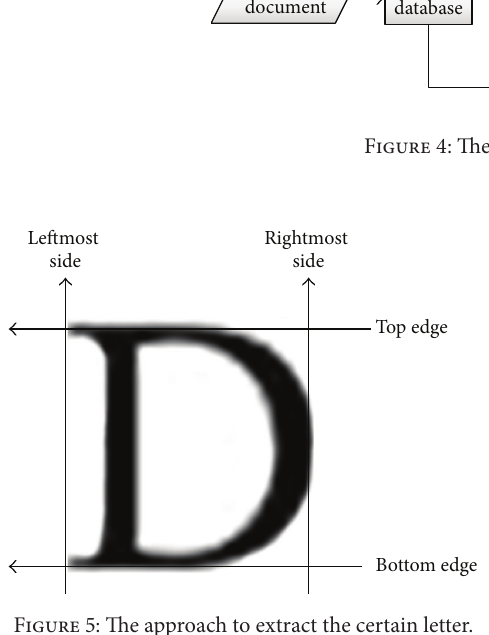
Figure 5: The approach to extract the certain letter.